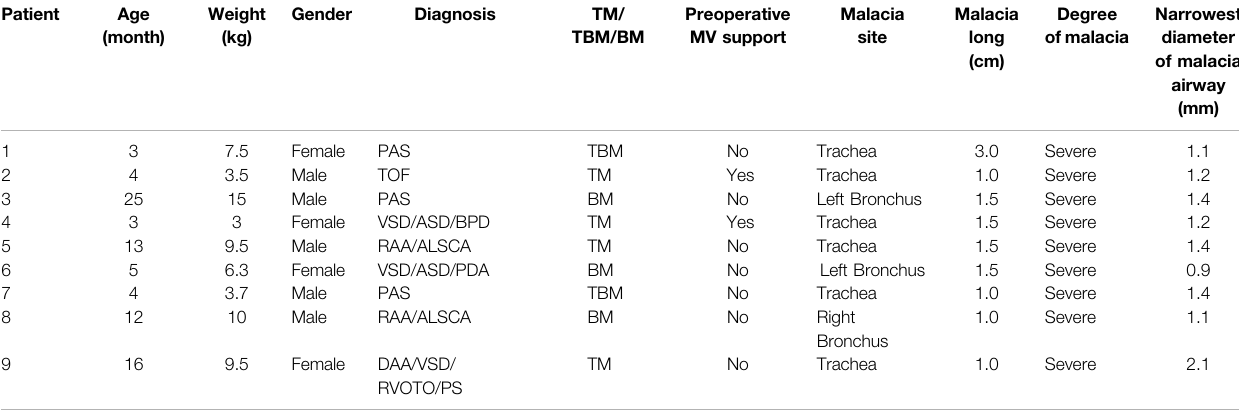
TABLE 1 | Characteristic of patients with 3D-printed bioresorable airway external splint.